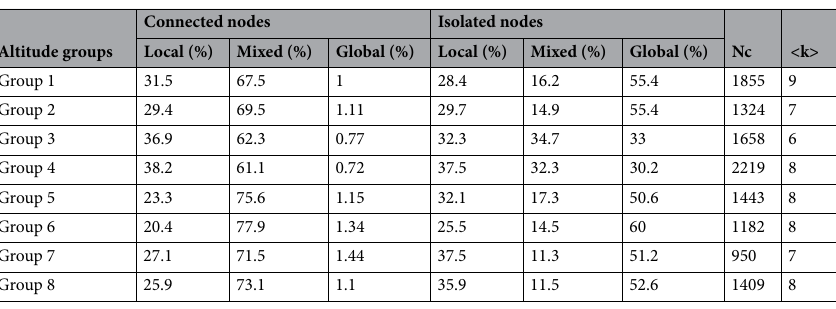
Table 3. Categorization of variable sites